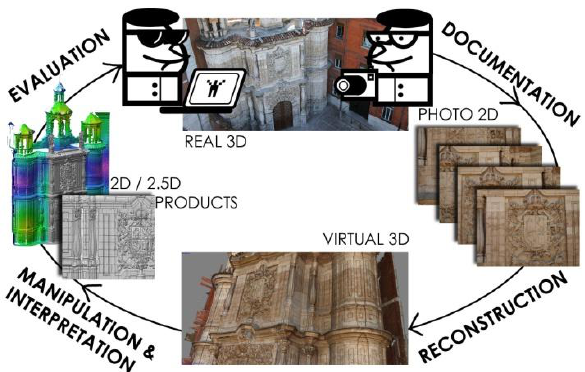
Figure 1: New “round trip” for generating digital products in Cultural